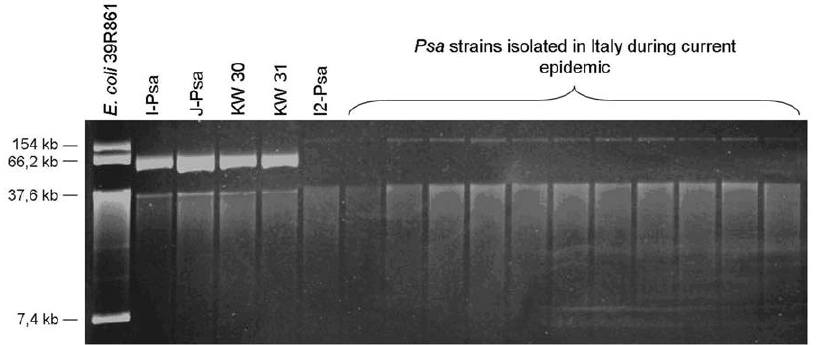
Figure 7. Plasmid profiles of Psa . Agarose gel electrophoresis to compare the number and size of native plasmids in the genome of Psa strains. The gels show also other representative Psa strains from the outbreak of bacterial canker in Japan (i.e. 1984) and from the current severe epidemics in Italy. See also Materials and Methods. Note as the ca. 50 kb plasmid present in J- Psa and I- Psa is not contained in all the Psa strains isolated from the current epidemic in Italy. By contrast, I2-Psa and other strains obtained from the recent epidemics of bacterial canker in Italy contain a plasmid of about 160 kb.